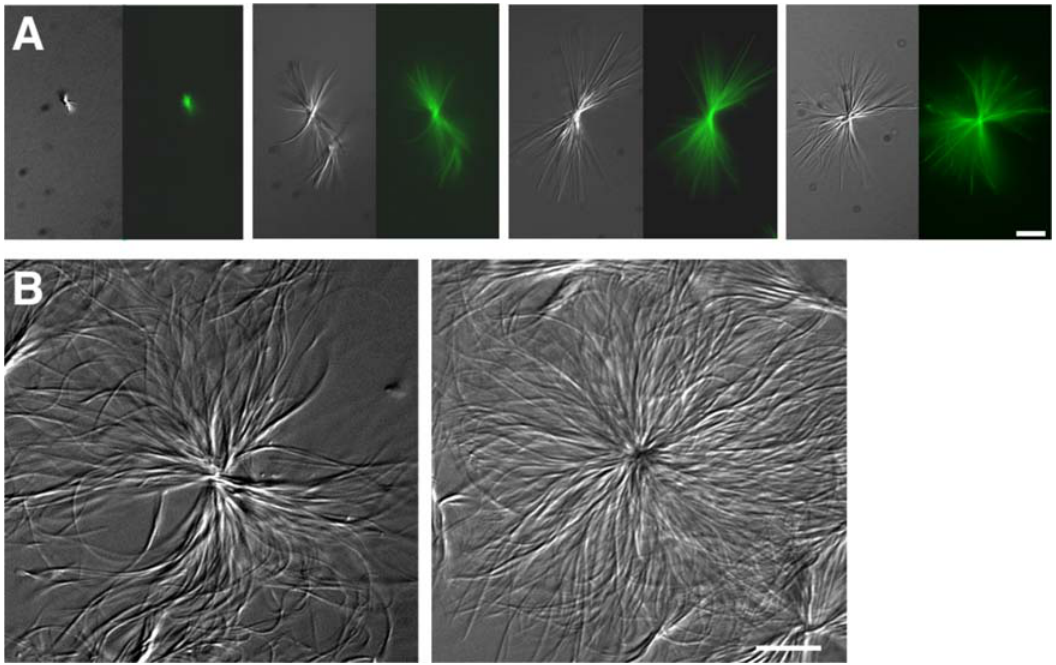
Figure 3. Concentration- and time-dependence of aster formation. (A) Fluorescently labeled Taxol-induced asters (DIC and fluorescent optics) formed in polymerization solutions stabilized with a concentration gradient of Taxol (left to right): 0.92 m M, 1.0 m M, 10 m M, 20 m M. Asters were not visible at or below 0.88 m M Taxol. These results are consistent with the low solubility of Taxol in aqueous solution [19]. (B) Taxol crystals, formed in 20 m M Taxol in aqueous buffer. Asters were visualized by DIC microscopy 24 hours after preparation. Compare to the smaller, less-dense aster in Fig. 1 B, which was visualized within 10–60 minutes. Crystals were not a solvent-induced artifact, as no structures were visible in a control solution lacking Taxol. Bars, 10 m